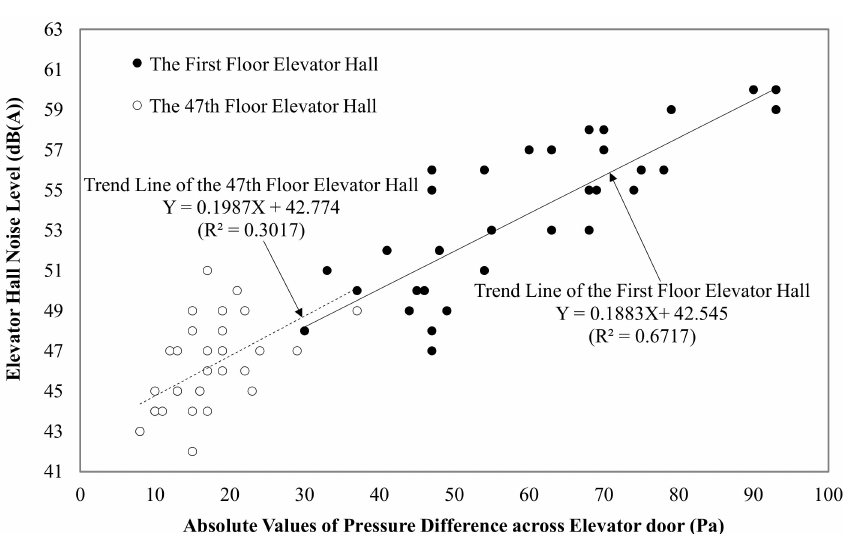
Figure 6. The pressure difference across the elevator doors is positively related to the NL on the 1st and 47th elevator halls. The measured values of pressure difference across the first-floor elevator door were as negative values.